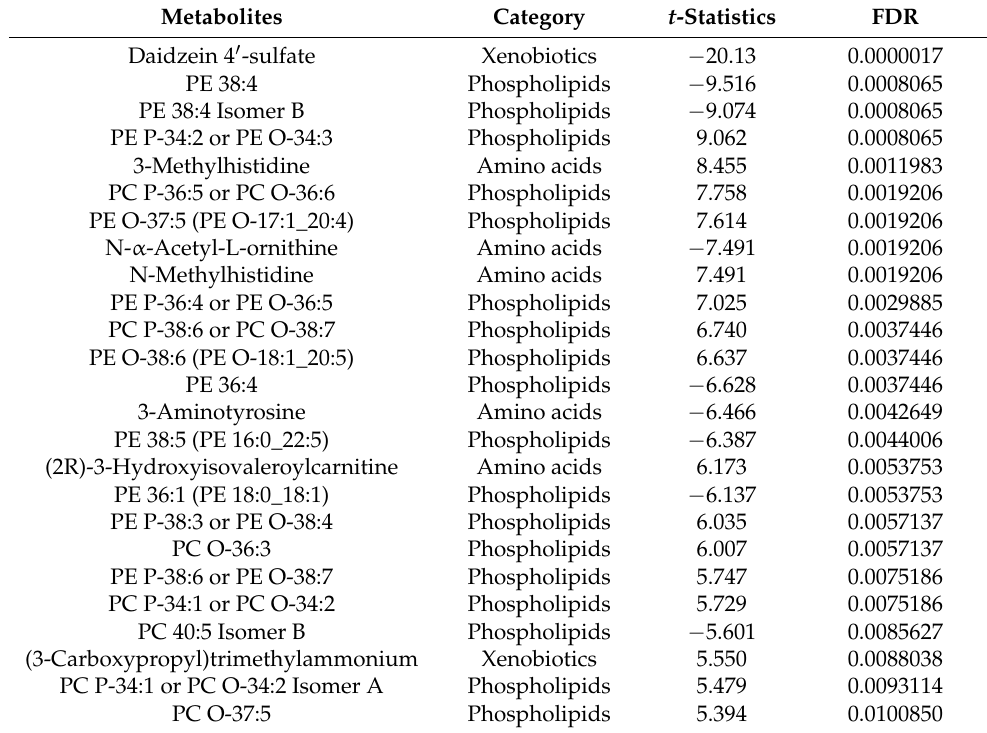
Table 2. Selected top 25 plasma metabolites.